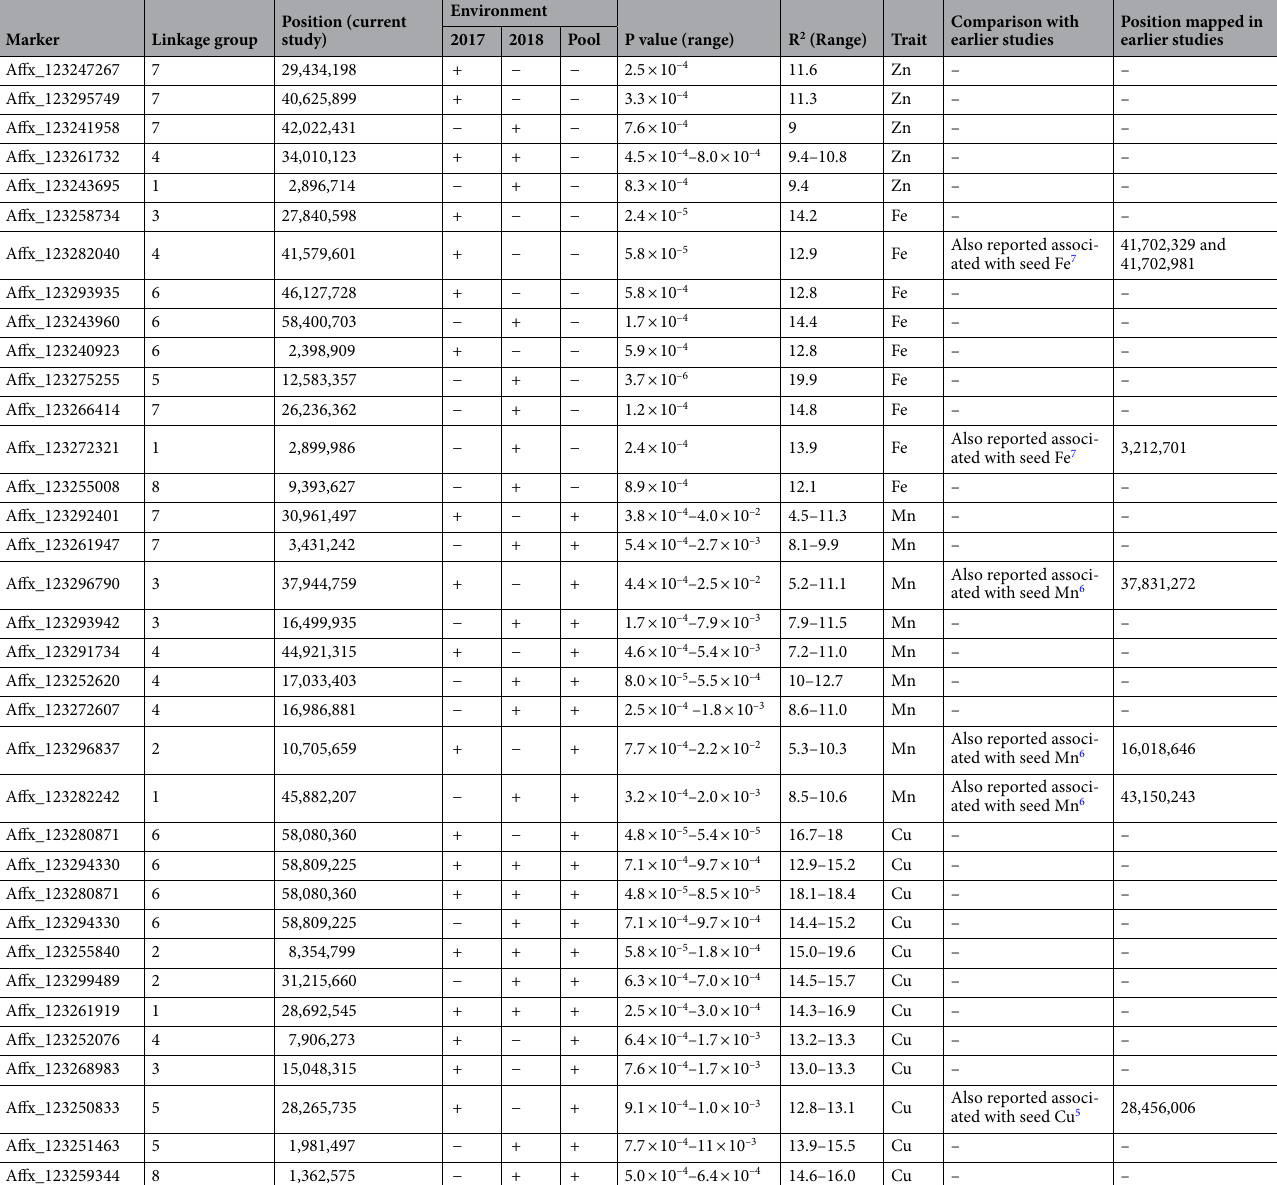
Table 5. Details of SNPs showing significant associations with seed Zn, Cu, Fe and Mn concentrations. The table shows the linkage group, position, environment of detection, and phenotypic variation explained (R2) by the marker-trait associations/SNPs identified during the present study. The table also highlighted the correspondence (validation) of some of the identified SNPs with some earlier identified genes/QTLs/SNPs for seed